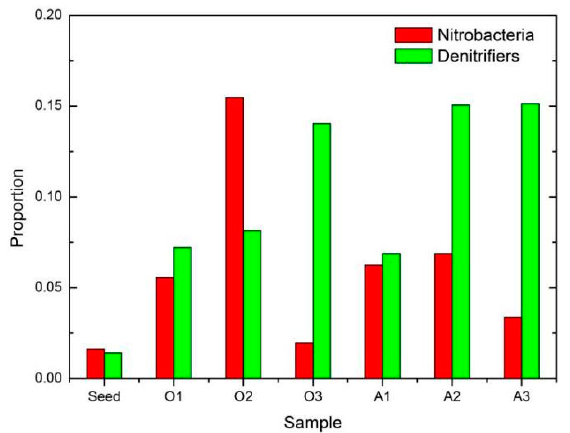
Figure 6. Distribution of nitrobacteria and denitri fi ers.